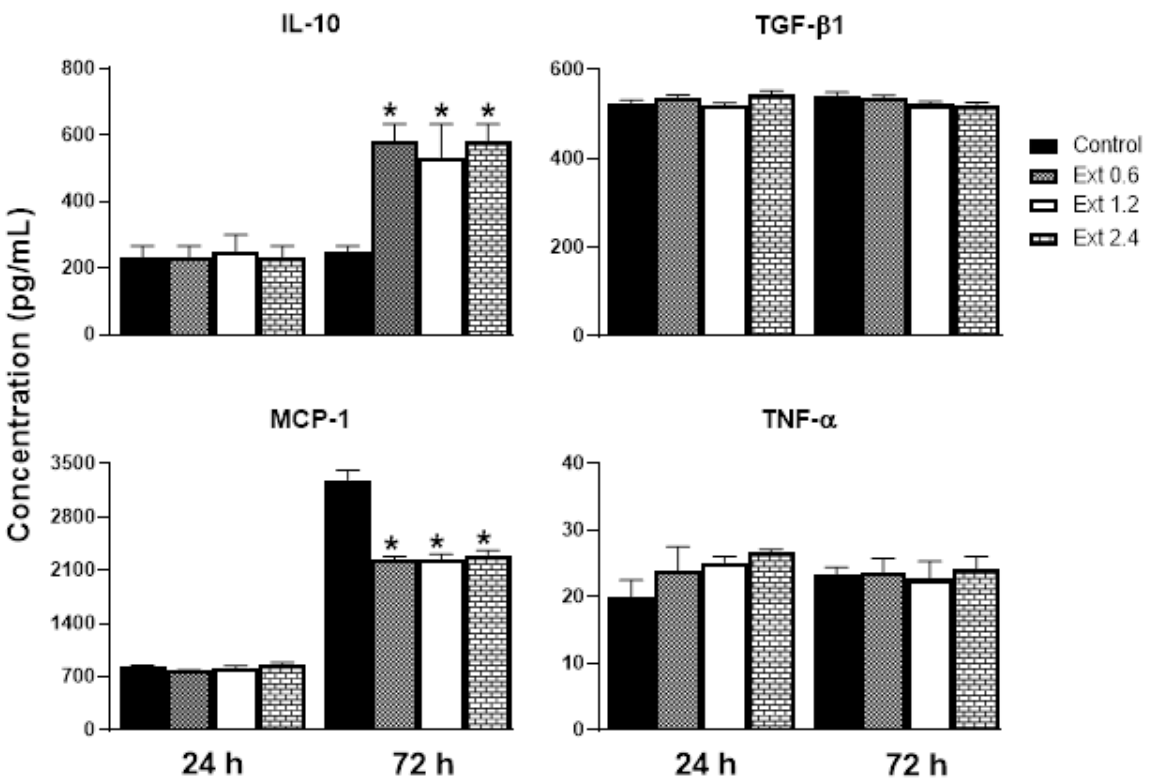
Figure 5. Effect of E. hyemale extract (Ext: 0.6, 1.2, and 2.4 mg/mL) on IL-10, TGF-β1, MCP-1, and TNF-α release from RAW 264.7 cells stimulated with LPS ( lipopolysaccharide ) after 24 and 72 h of treatment. * p < 0.05 versus control.